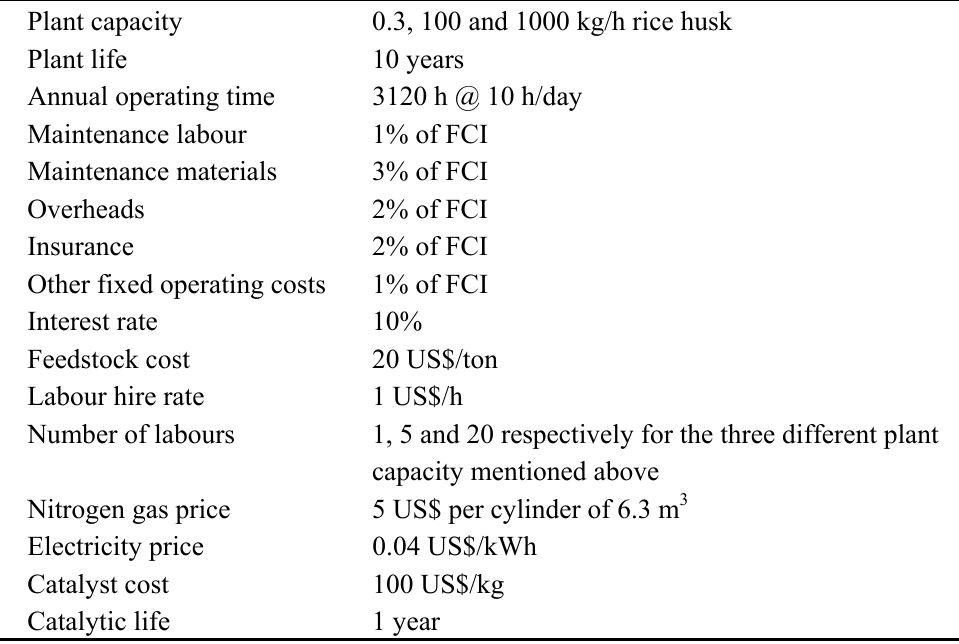
Table 11. Parameters used in production cost calculation